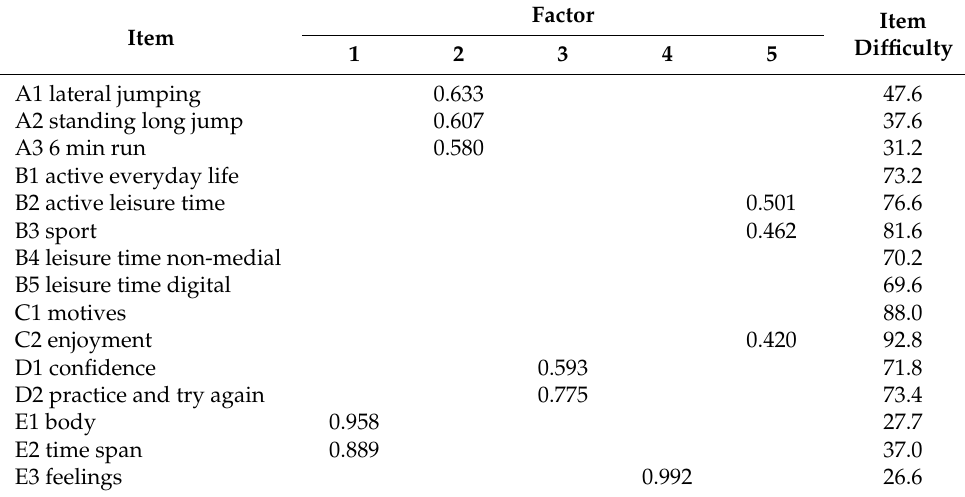
Table 3. Rotated factor matrix of the exploratory factor analysis.